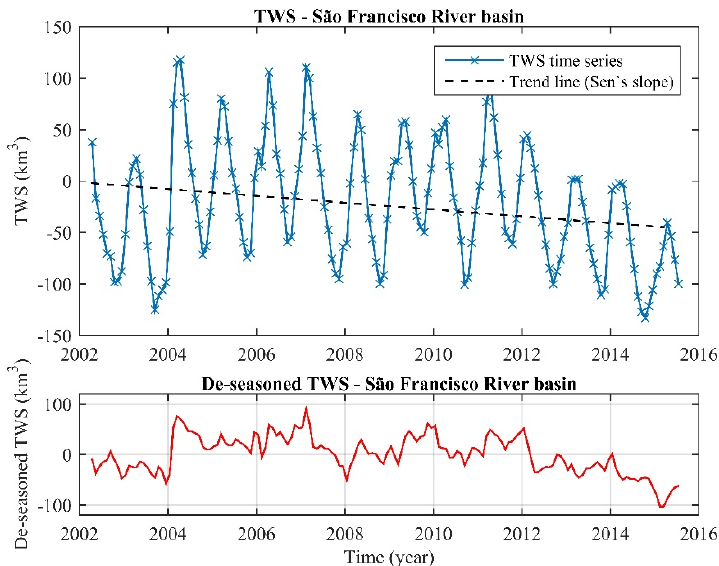
Figure 3. Top panel: GRACE-derived TWS time series (blue solid line) averaged within the SFRB (delineated by the white solid line in Figure 1) using Equation (8). Additionally, it also shows the linear trend (black dashed line) computed over the time span of April 2002 to March 2015 (13 years); Bottom panel: residual time series (de-seasoned TWS) computed as the difference between the TWS time series (top panel) and the 160-month climatology (April 2002 to July 2015). That is, this residual time series depict the deviation from the normal annual (seasonal cycle), which provide the excess/deficit where relatively dry periods are characterized by negative residuals and relatively wet periods by positive residuals.